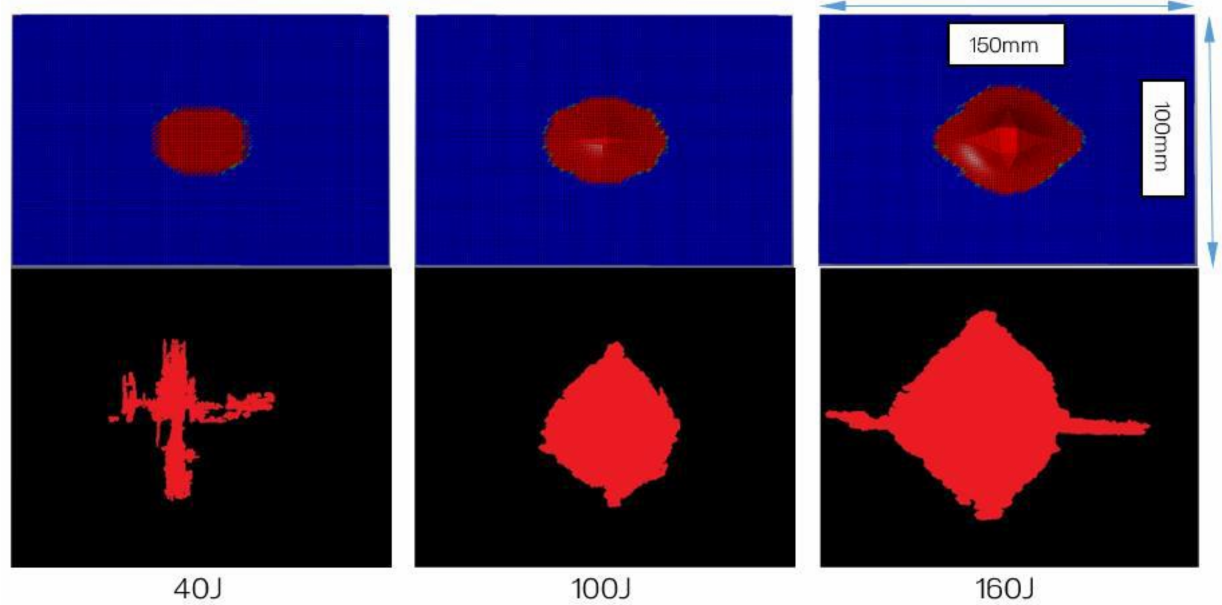
Figure 16. Damage area (envelope) computed by the numerical simulations (top three images) and damage area gathered following the experiments through X-rays for T700/PA6.6. Each image represents an overall panel with dimensions of 150 mm × 100 mm.